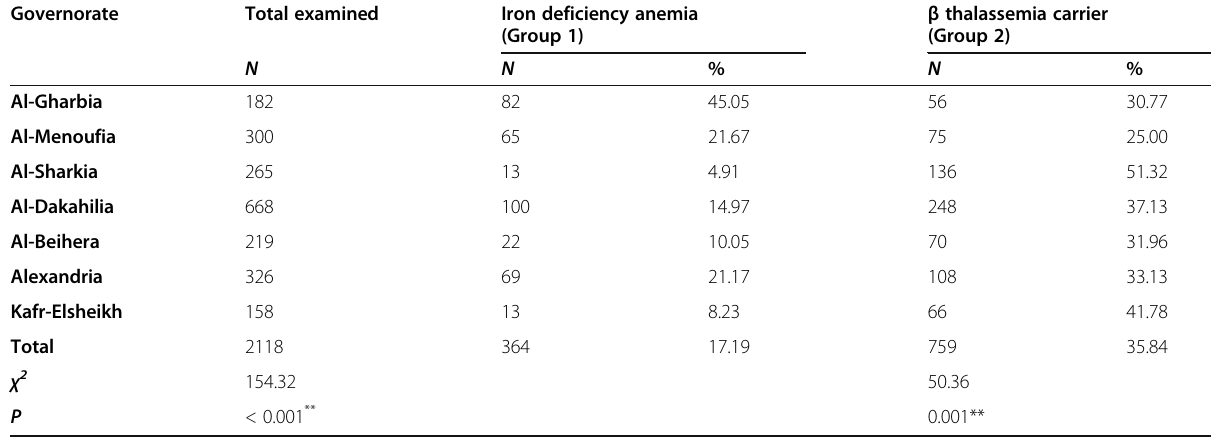
Table 1 Prevalence of iron deficiency anemia and β thalassemia carriers among studied relatives in Mid Nile Delta